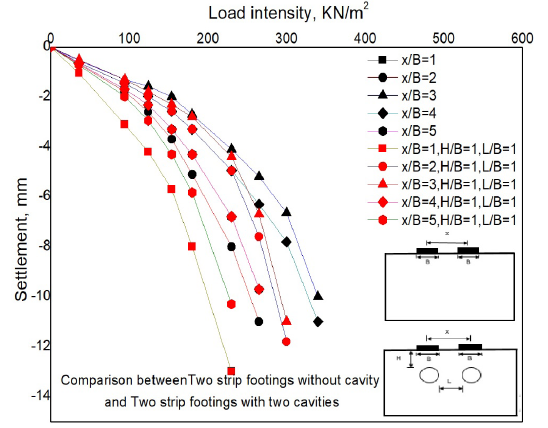
Figure 5: Load-settlement curve of isolated footing without cavity, isolated footing with cavity (H/B = 1), and isolated footing with two cavities (H/B = 1 and L/B = 1).